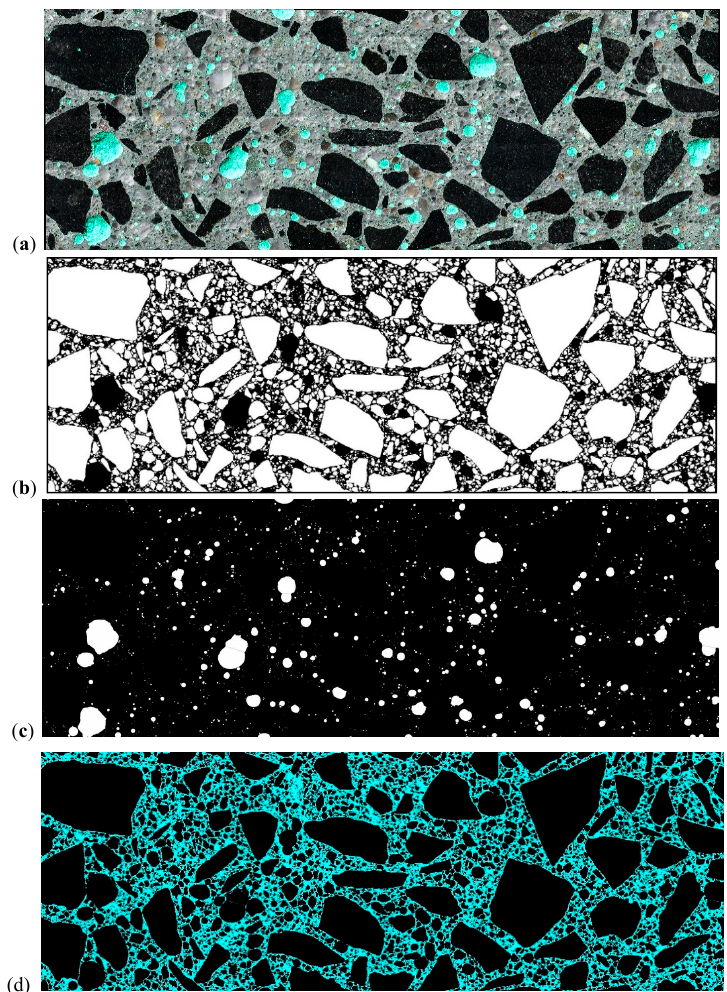
Figure 5. Image of the test surface: ( a ) ordinary light, voids filled with fluorescent powder, ( b ) binary image of aggregate particles, ( c ) binary image of voids and ( d ) binary image of cement paste, marked in Table 3. Microscopic measurement results.